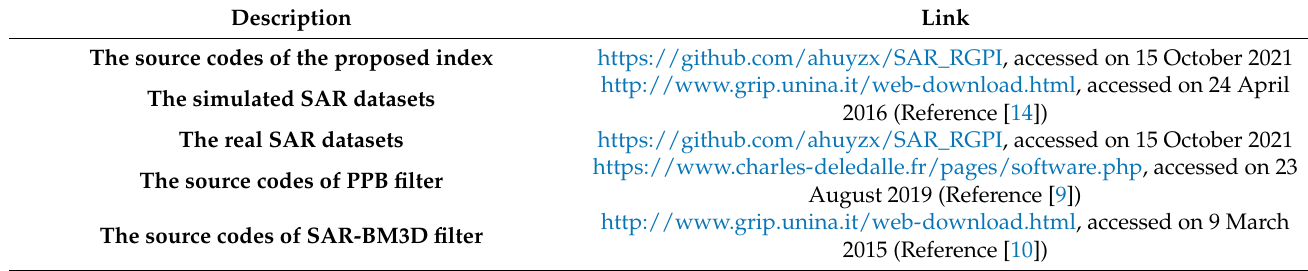
Table A1. The links to some source codes and testing datasets used in this